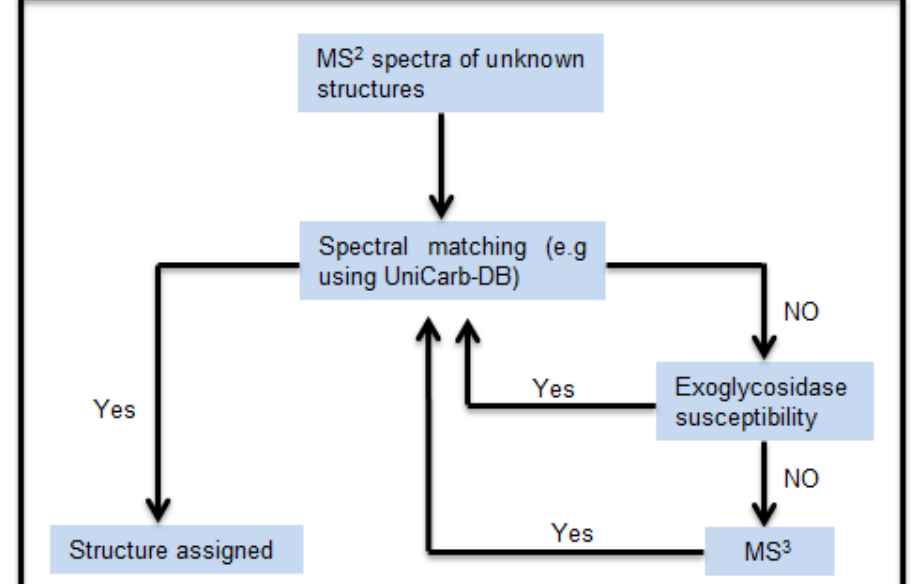
Figure 1. Schematic workflow for structural assignment of O -glycans using MS n spectral match. The MS 2 peak list of the isolated chromatographic peak were compared and scored with the peak list of the structure reported in the MS 2 database UniCarb-DB. Poor scoring resulted in exoglycosidase digestion and concomitant scoring of MS 2 spectra of the generated product. In absence of successful exoglycosidase digestion, MS 3 were generated for spectral